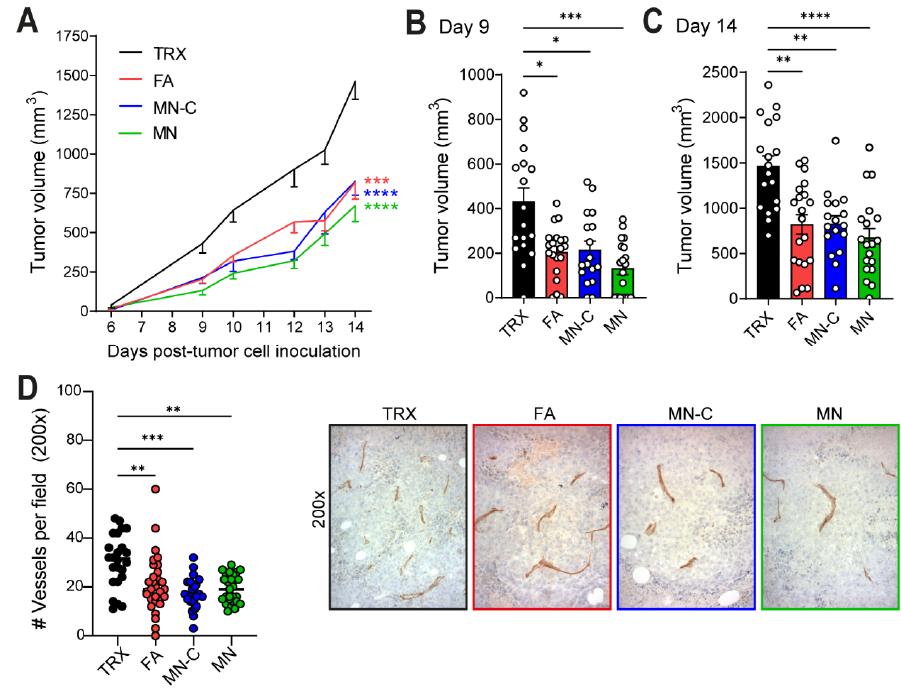
Figure 3. B16F10 melanoma tumor growth and tumor vessel density after vaccination against extra- cellular vimentin. ( A ) Pooled tumor growth curves of B16F10 melanoma in vaccinated mice of